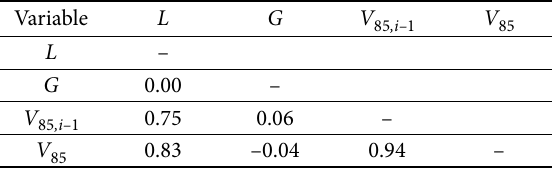
Table 5. Correlation matrix for geometric characteristics, de- sign speed and operating speed for tangent elements ( n = 20) Variable